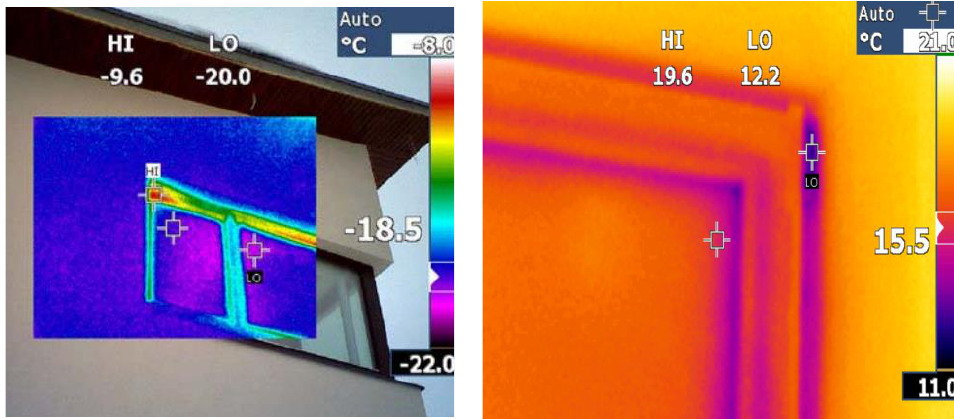
Figure 1. Thermal images of thermal bridges at window openings.